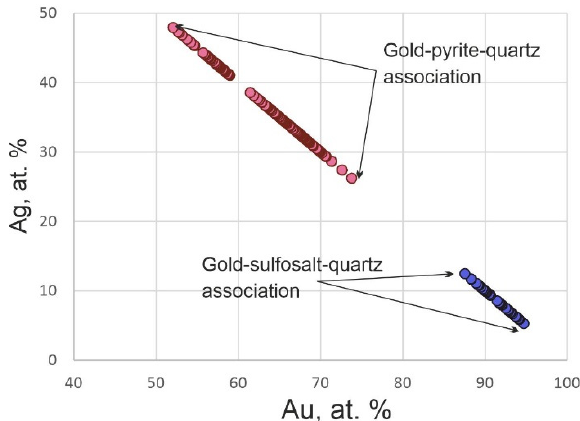
Figure 13. Compositions of Au-Ag alloys (at.%) in both associations of the Baranyevskoye deposit. Similar textures were previously described at the Aginskoye deposit [11]. According